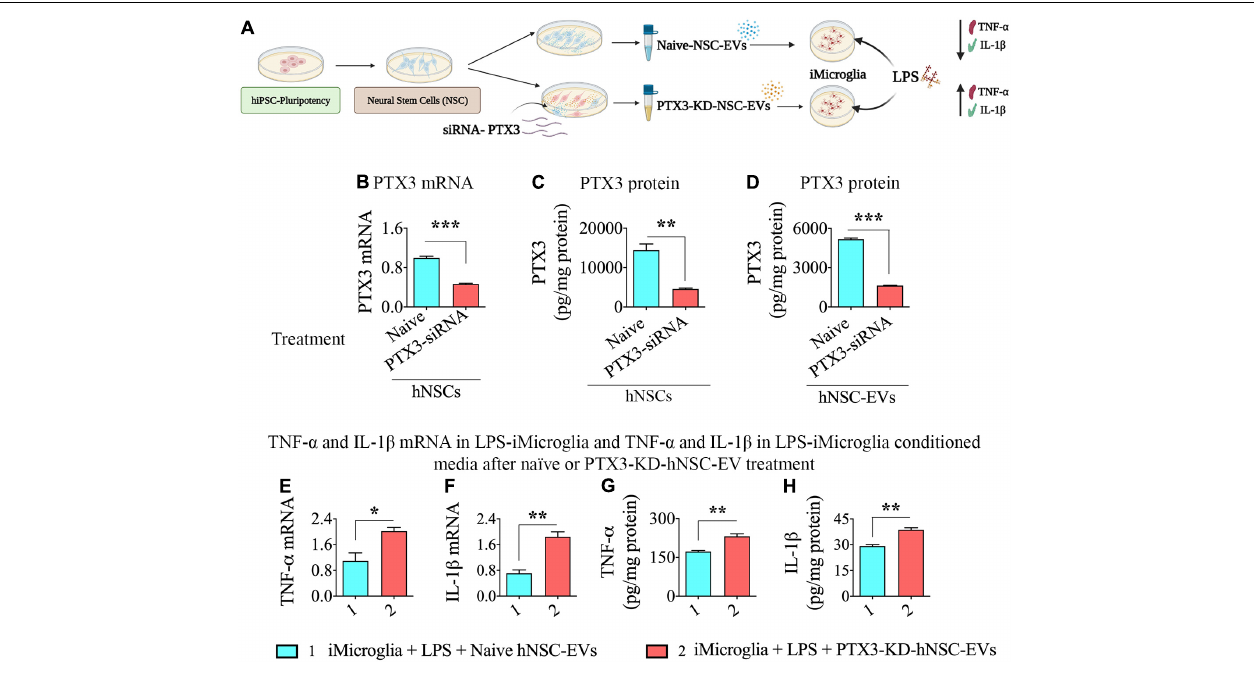
FIGURE 5 | Human neural stem cell-derived extracellular vesicle (hNSC-EVs) with reduced expression of pentraxin 3 (PTX3) mediated diminished antiinflammatory activity on lipopolysaccharide (LPS) stimulated iMicroglia. (A) Is a schematic showing the design for this experiment. The bar charts in (B–D) show reductions in PTX3 mRNA expression in hNSCs (B) , PTX3 protein concentration in the hNSC lysate, and PTX3 protein concentration in hNSC-EVs (C) after PTX3-siRNA treatment. The bar charts in (E,F) illustrate that LPS-stimulated iMicroglia display higher expression of tumor necrosis factor-alpha (TNF- α ; E ) and interleukin-1 beta (IL-1 β ; F) mRNA expression when treated with hNSC-EVs with reduced expression of PTX3 (PTX3-knockdown [KD]-hNSC-EVs), in comparison to naïve hNSC-EVs. The bar charts in (G,H) show that LPS-stimulated iMicroglia release higher levels of TNF- α (G) and IL-1 β (H) into the culture media when treated with hNSC-EVs with PTX3-KD-hNSC-EVs, in comparison to naïve hNSC-EVs. * p < 0.05; ** p < 0.01; *** p < 0.001.